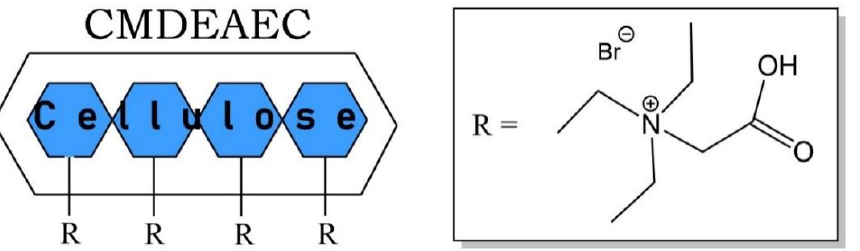
Figure 3. A general structural representation of carboxymethyl-diethyl ammonium ethyl cellulose (CMDEAEC) [36]. (CMDEAEC)